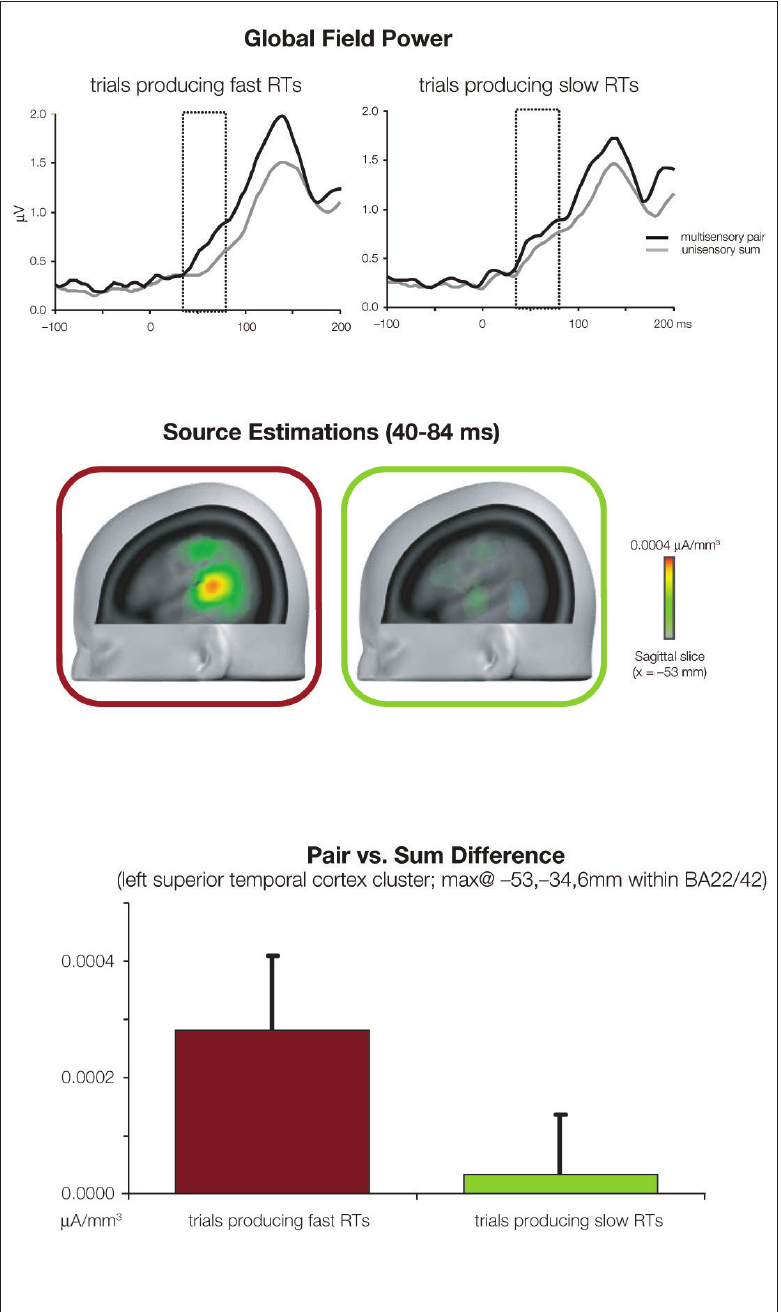
Figure 3 | Evidence for the impact of early non-linear and supra-additive neural response interactions on RT speed. The top panels illustrate global field power waveforms in response to multisensory stimulus pairs, and the summed unisensory responses for trials producing fast and slow RTs (left and right panels, respectively). While non-linear neural response interactions began at 40 ms post-stimulus for trials producing fast RTs, such was only the case from 86 ms onwards for trials producing slow RTs. The middle portion illustrates the difference in source estimations over the 40–84 ms post-stimulus period between responses to multisensory stimulus pairs and summed unisensory responses for trials producing fast and slow RTs (red and green framed images, respectively). The sagittal slice is shown at x = − 53 mm using the Talairach and Tournoux (1988) coordinate system. The bottom panel illustrates the mean scalar value of differential activity within a cluster of 25 solution points within the left superior temporal cortex. There were significantly greater non-linear multisensory neural response interactions in the case of trials producing fast